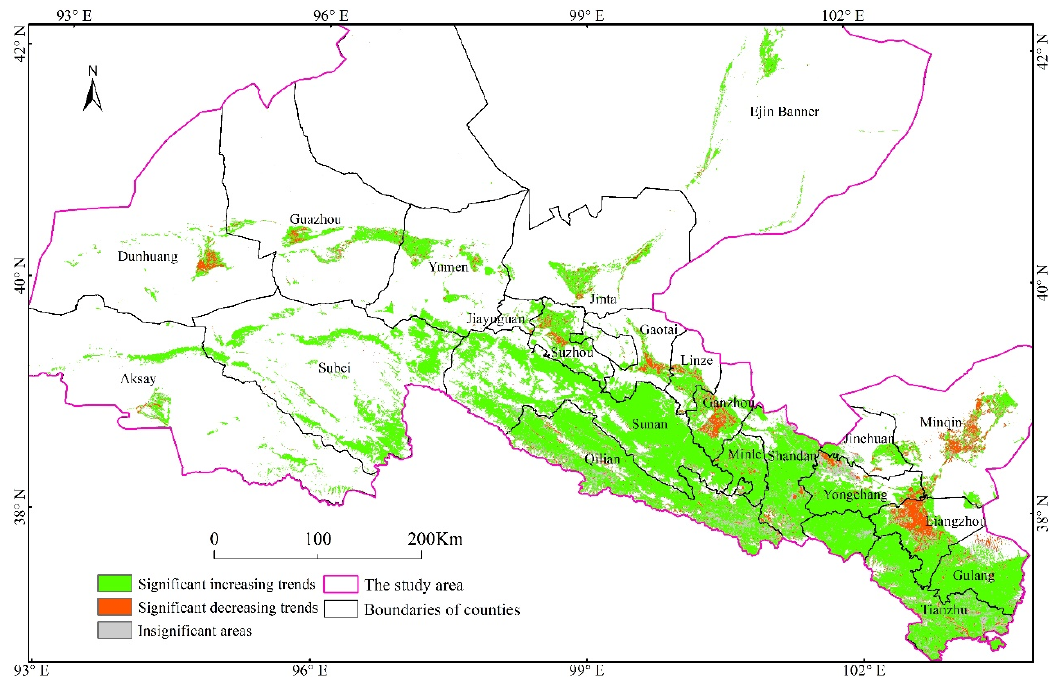
Figure 4. Trends of vegetation changes in the Hexi region of northwest China detected by the method proposed in our previous study [49]. Only vegetation covered areas with the maximum gNDVI over the period 2001 − 2017 with not less than 0.2 were discussed in our study.